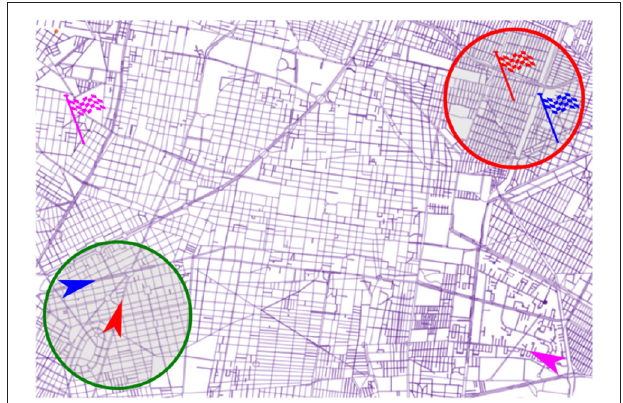
FIGURE 1 | The map represents a portion of any street network. Arrows represent bike riders, same colored flags their destinations. The green circle shows the radius of red’s local altruism, i.e., what distance surrounding her she’s willing to cover in order to join with others. The red circle shows red’s destination altruism, i.e., what distance surrounding her destination is close enough to include in her trip. Red and blue cyclists are great candidates for forming a flock: by riding a short distance they can meet and share most of the trip. Pink cyclist however is not a good match, he is far away and riding in the opposite